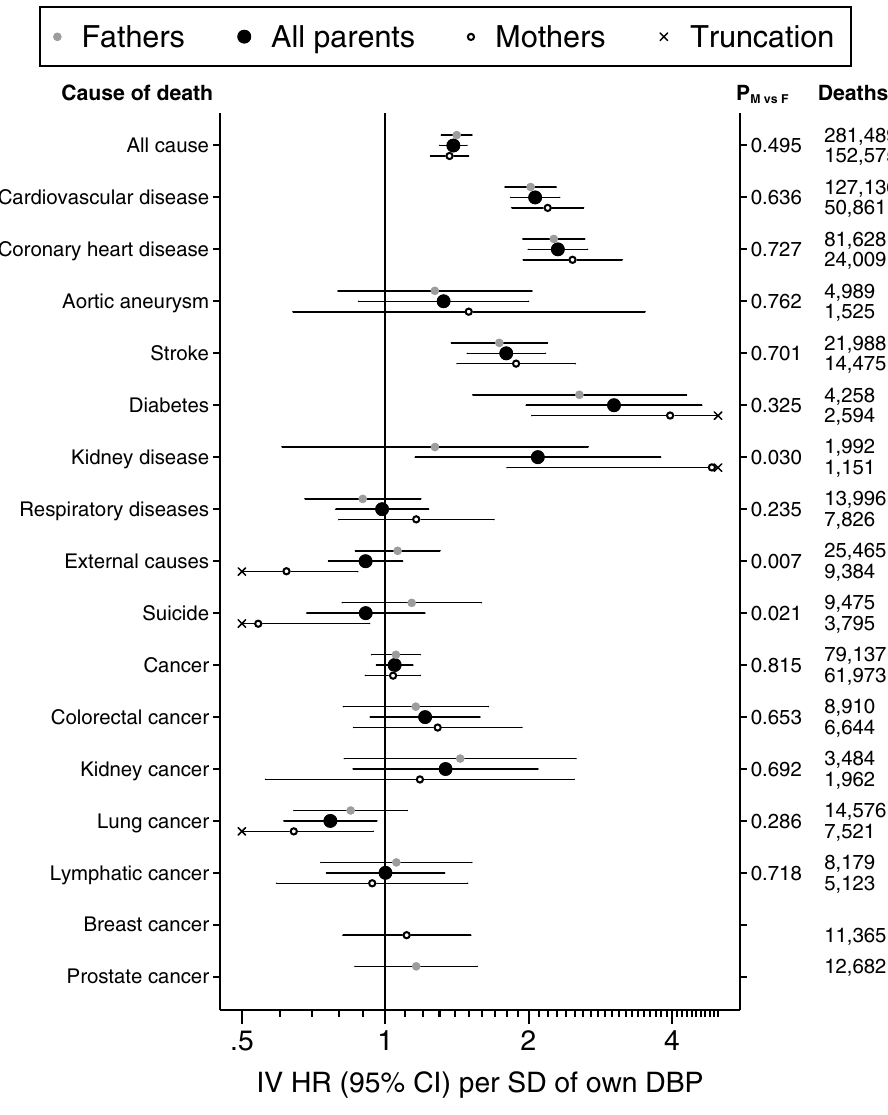
Figure 2. A correct version of the original Figure